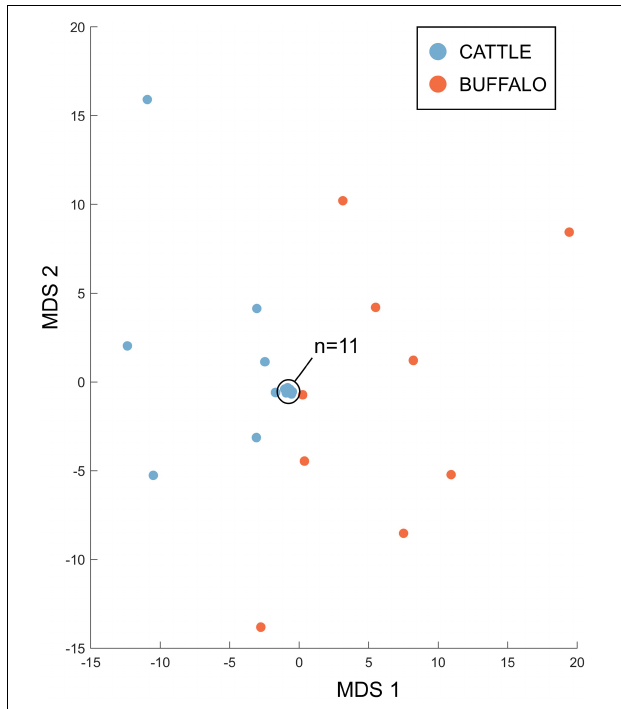
FIGURE 8 | Multidimensional scaling analysis incorporating counts for non-singleton alleles from samples for which data was generated for all three antigens. Data across the three antigens were integrated; the first two dimensions are shown. Cattle samples ( n = 18) are represented in blue and buffalo samples ( n = 9) in